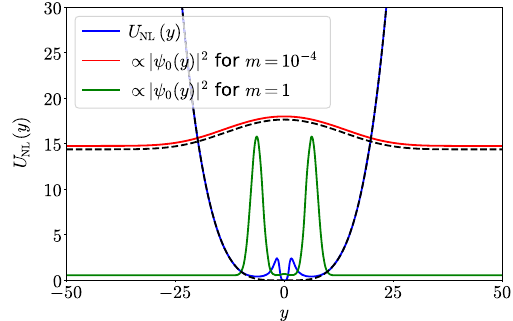
y Þ in Eq. (22) (blue) FIG. 5. Pathological potential U NL ð together with the ground-state wave function of the Hamiltonian in Eq. (21) for m ¼ 10 − 4 (red) and m ¼ 1 (green). Different choices of m correspond to different values of the internal shunting capacitance. For m ¼ 10 − 4 , the ground-state wave function of the potential y 4 = 10 4 is shown for comparison (black dashed lines for both wave function and potential). For better visibility, all wave functions are scaled by a factor 10 and shifted by their corresponding ground-state energies.